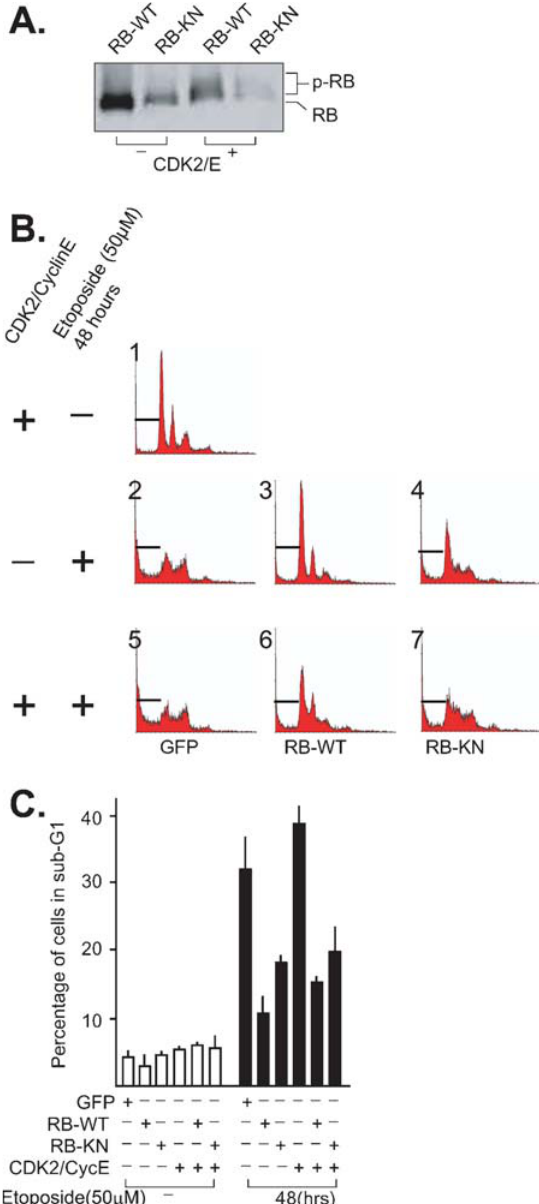
Figure 5. RB retains anti-apoptotic function in proliferating cells. A) RB phosphorylation by Cdk2/Cyclin E in SAOS-2 cells. Cells were infected with recombinant adenovirus expressing RB or RB-KN, in the absence or presence of co-infection with recombinant adenovirus expressing Cdk2 and Cyclin E. The electrophoresis mobility of RB was examined by immunoblotting of whole cell lysates with anti-RB. B) Representative FACS profiles. SAOS-2 cells infected with the indicated recombinant adenoviruses were treated with 50 m M etoposide, harvested 48 hours later, fixed, stained with propidium iodide and the DNA content analyzed by FACS. The gate for sub-G1 DNA fraction is shown in each profile. C) Summary of DNA fragmentation results. The sub-G1 DNA content was determined by FACS analysis as illustrated in panel B. The values are mean and standard errors from three independent